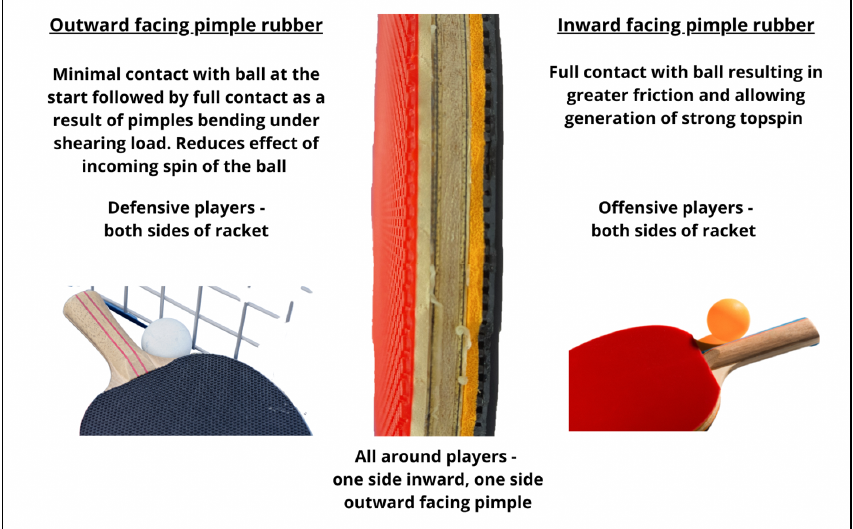
Figure 2. Commonly used rubber coverings on table tennis rackets and their impact on table tennis playing styles.